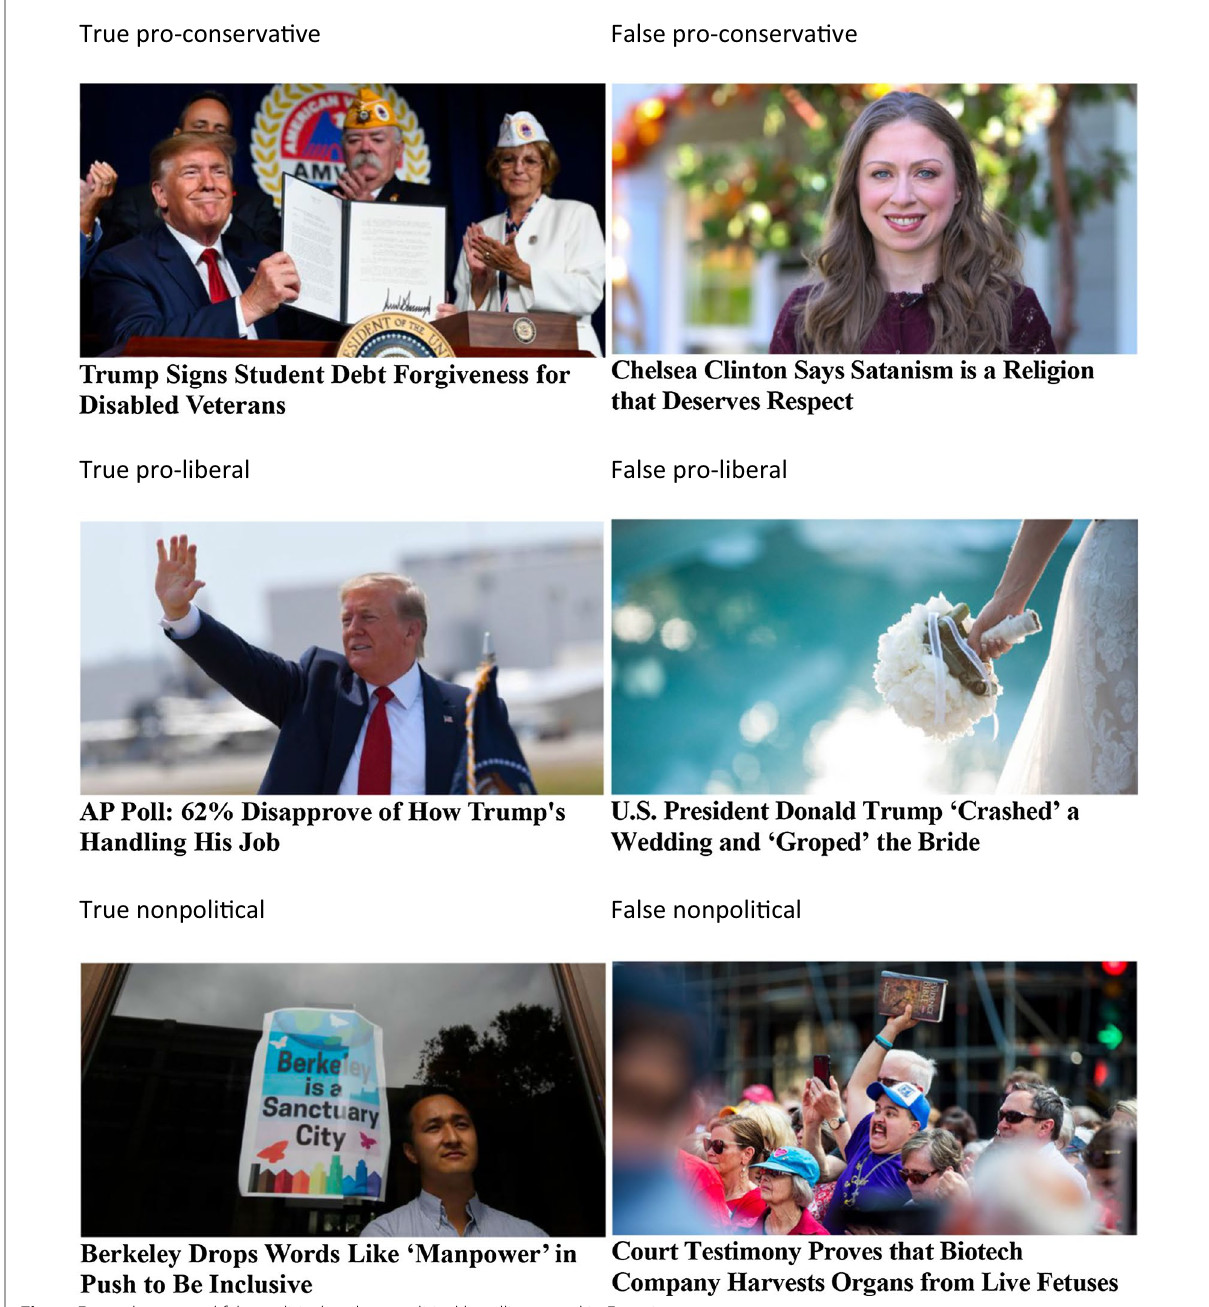
Fig. 1 Example true and false political and nonpolitical headlines used in Experiment